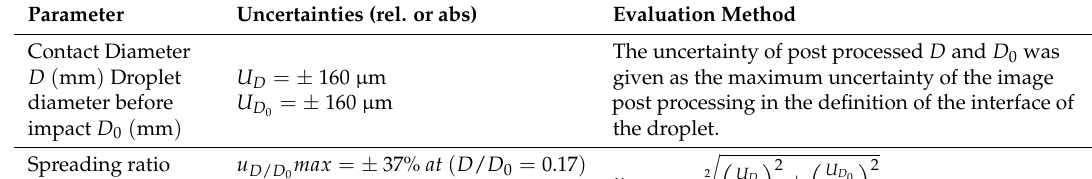
considering a vertical displacement of the droplet ∆ y in the time interval between three consecutive frames i.e., 1.5 ms. V 0 ∆ y ± Uy is the velocity that would result from a displacement equal to ∆ y ± Uy in the same interval between three consecutive frames. Uy is considered to be ± 1 pixel (40 µ m) in the optical arrangement